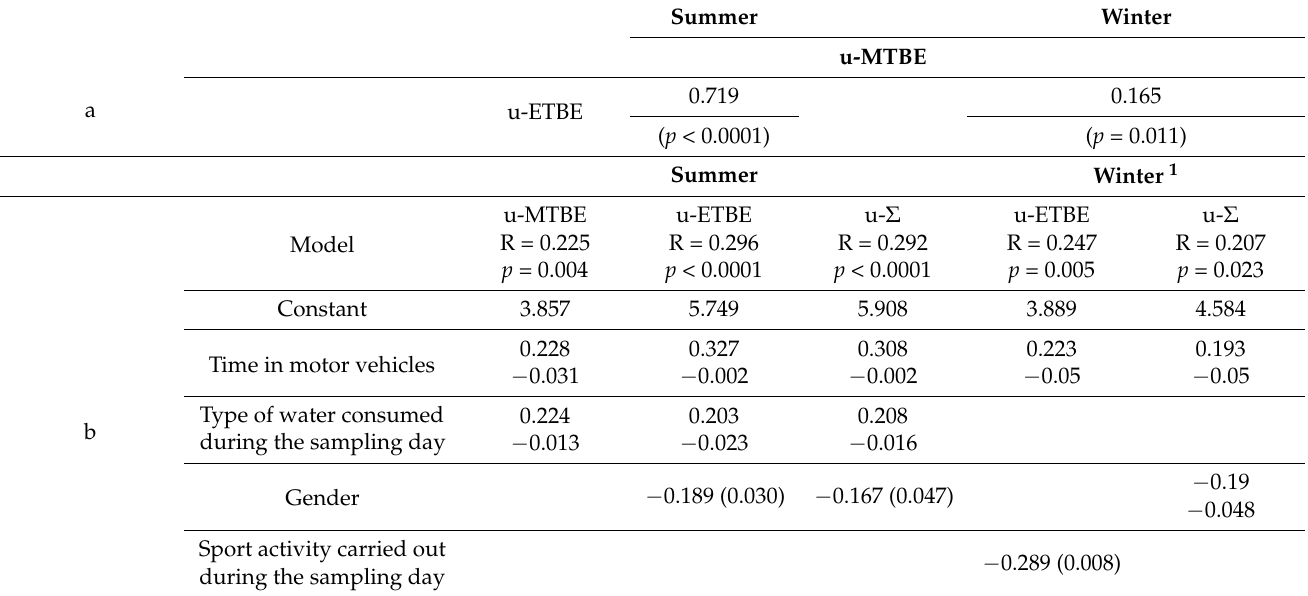
Table 3. (a) Pearson’s correlation coefficients between u-MTBE and u-ETBE in children classified by sampling season (summer and winter); (b) Significant predictors of urinary excretion of biomarkers of traffic-related pollutants according to multiple linear regression